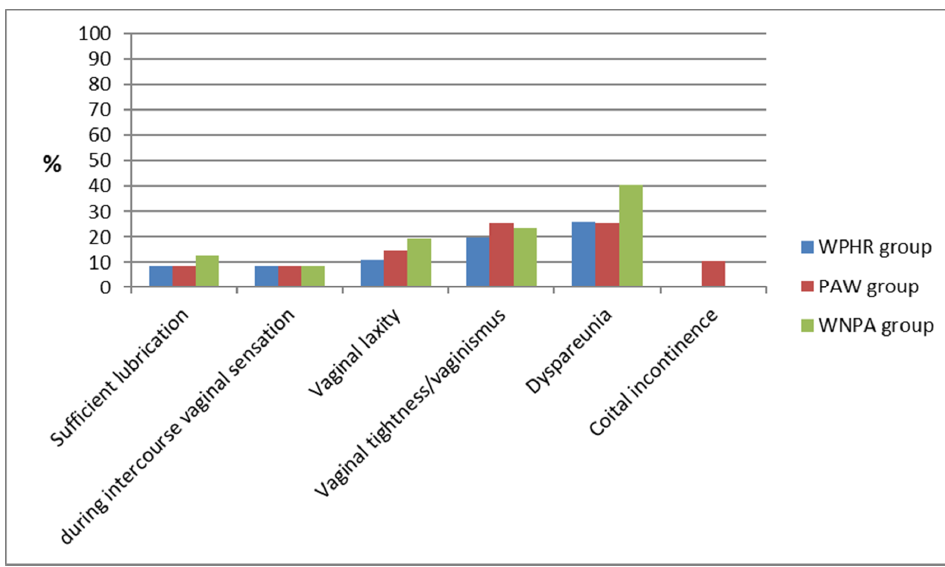
Figure 5. Occurrence of sexual dysfunction symptoms by groups.